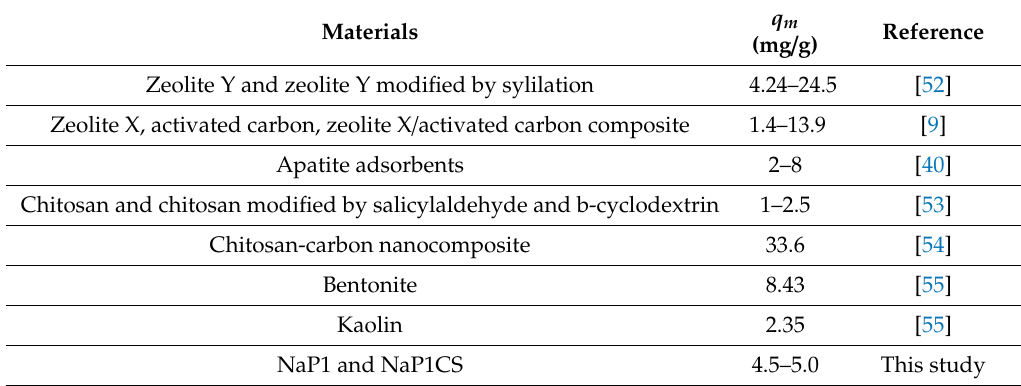
Table 2. Phenol adsorption capacity for di ff erent